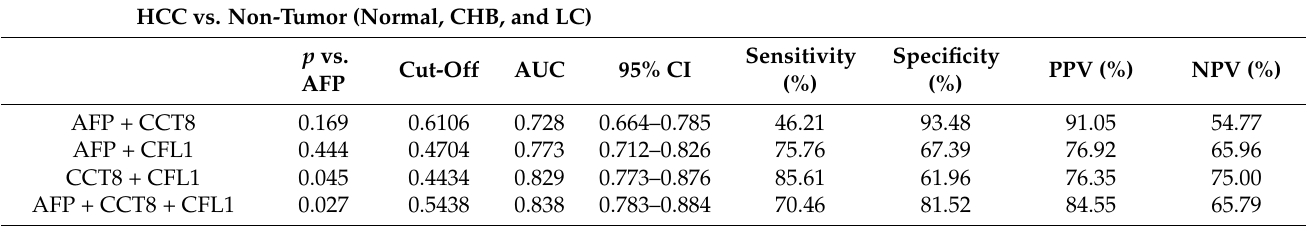
Table 3. Combination of serum exosomal protein markers and AFP in HCC diagnosis. HCC vs. Non-Tumor (Normal, CHB, and LC) p